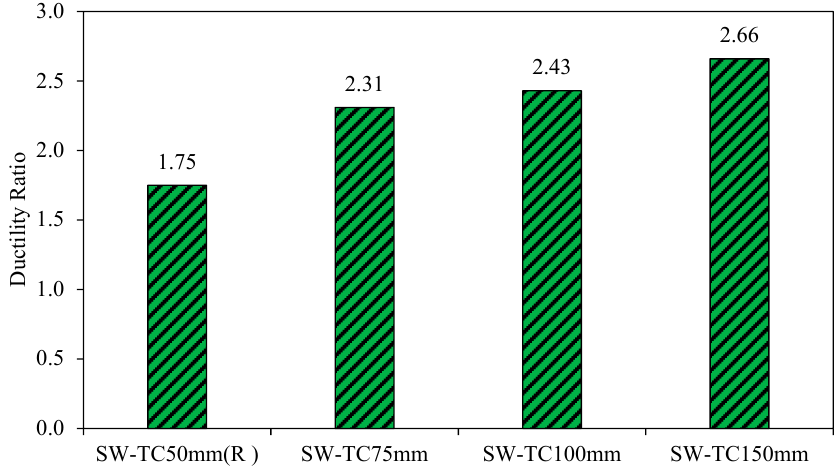
Figure 22. Ductility ratio of group 3.